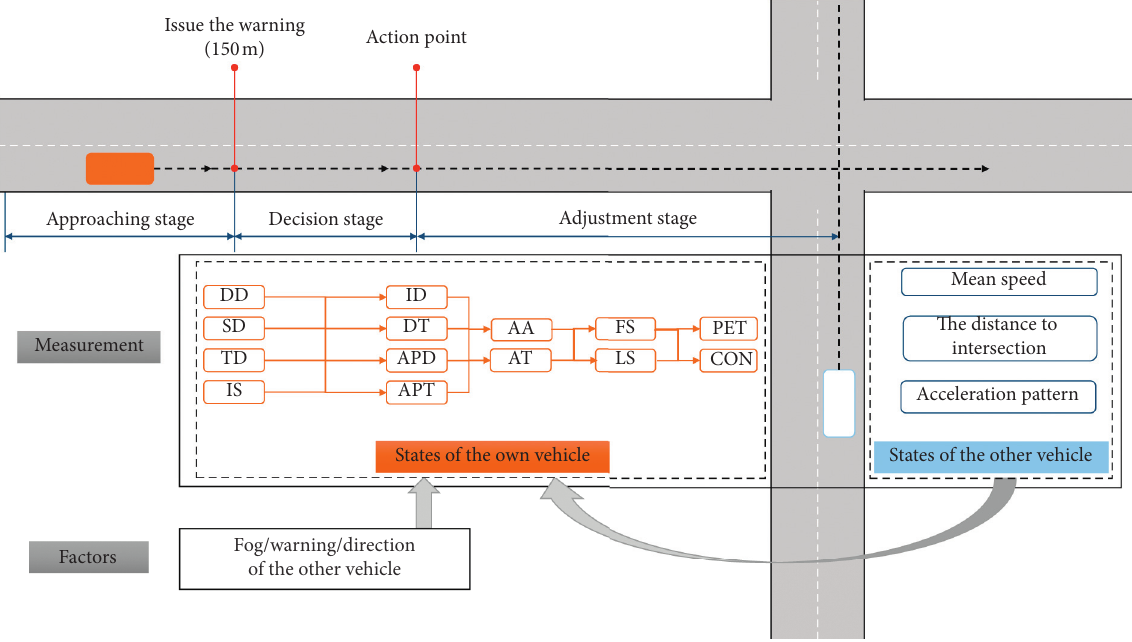
Figure 6: Drivers’ interaction process in unsignalized intersection.